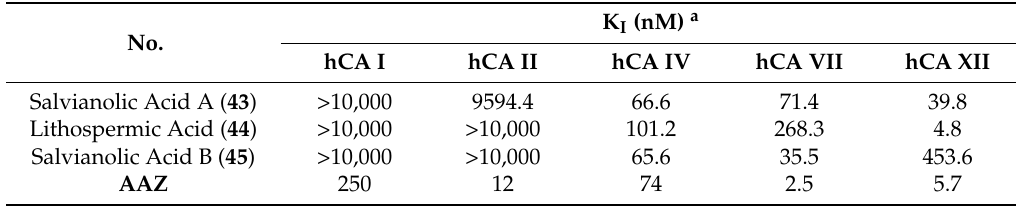
Table 5. Inhibition data of human CA isoforms hCA I, II, IV, VII and XII with salvianolic acids 43 – 45 reported here and the standard sulfonamide inhibitor acetazolamide ( AAZ ) by a stopped flow CO 2 hydrase assay [58].